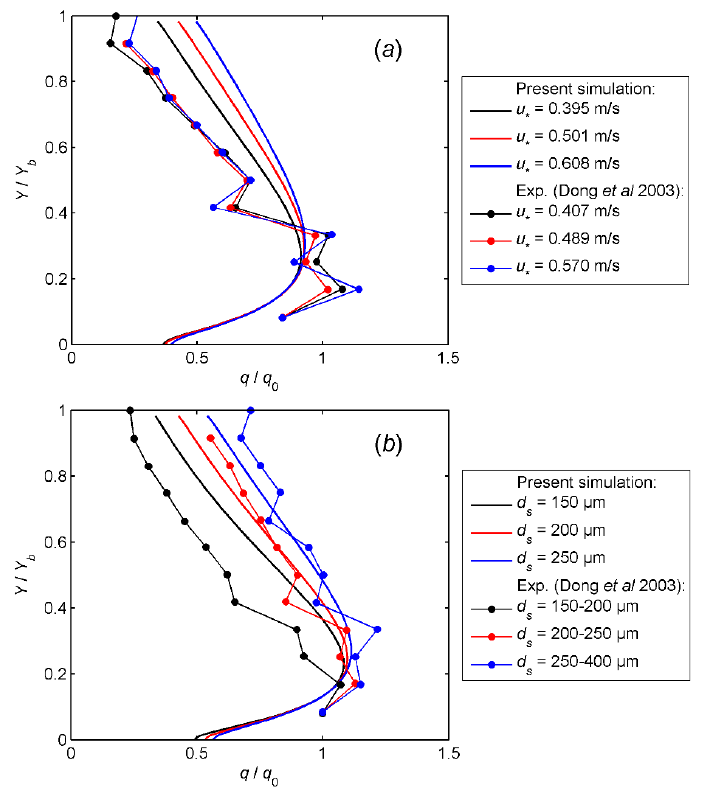
Figure 4. Variations with height of the average sand mass flux. ( a ) The profile varies with friction velocity. d s equals 250 µ m and 200–250 µ m for the present simulation and Dong, respectively [43]. velocity. d s equals 250 μ m and 200 – 250 μ m for the present simulation and Dong, respectively [43]. ( b ) ( b ) The profile varies with particle size. u ∗ equals 0.395 m / s and 0.407 m / s for the present simulation The profile varies with particle size. u  equals 0.395 m/s and 0.407 m/s for the present simulation and and Dong, respectively Dong, respectively [43].